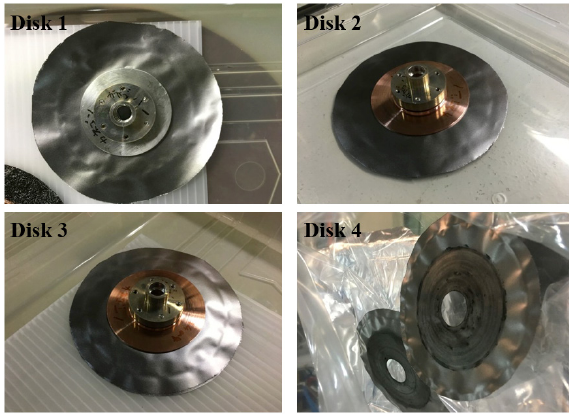
Fig. 1. Four GS-disks after the beam times.